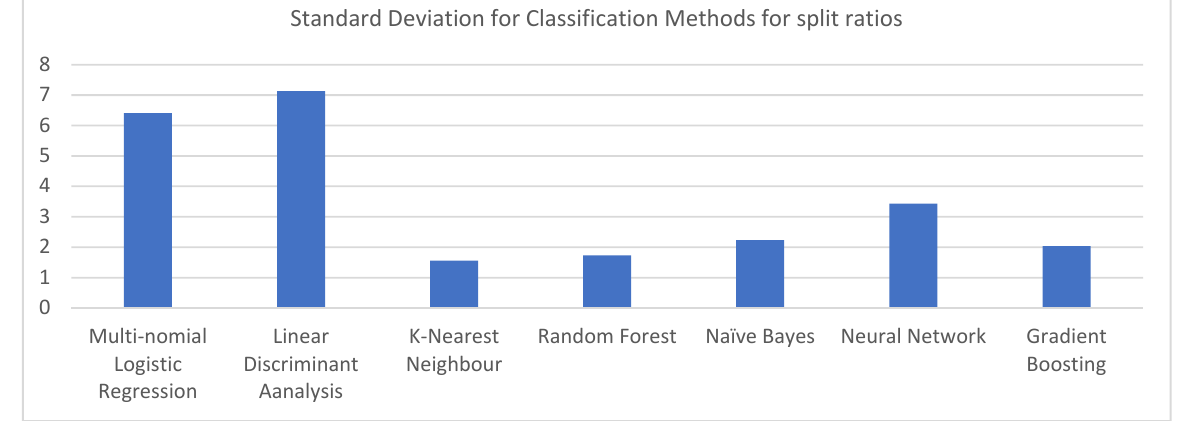
Figure 3. Standard deviation of accuracy of different classification methods for different split ratios.